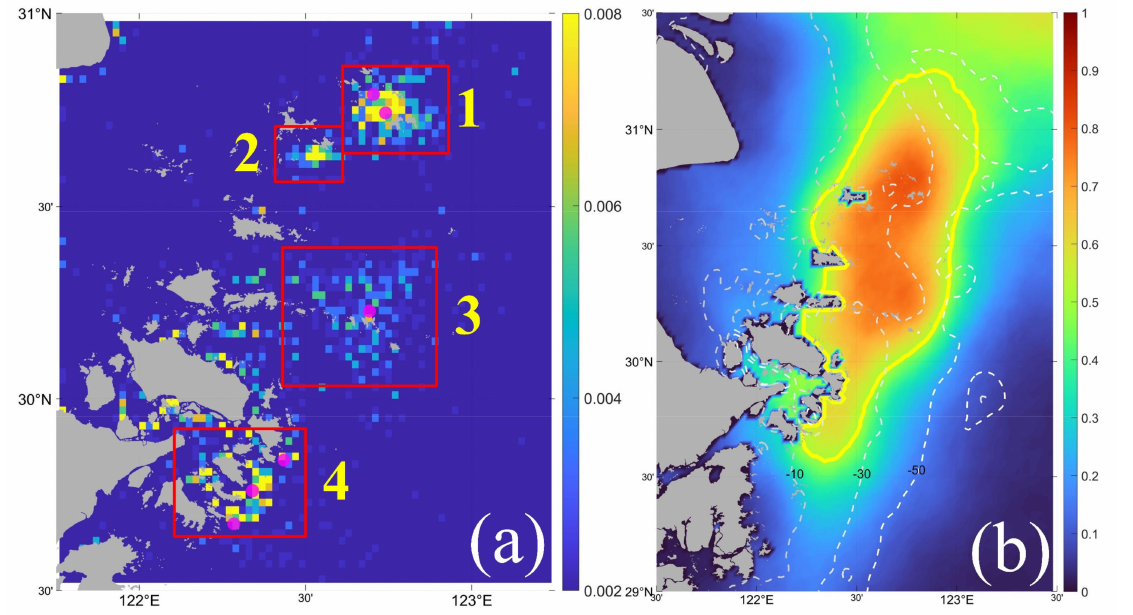
Figure 7. The spatial cumulative frequency map of potential upwelling points ( a ) and core area ( b ) from April to September, 2015–2021. The red boxes in panel ( a ) shows the aggregation area of potential upwelling points. The magenta dots in panel ( a ) show the location of the six national marine ranching demonstration areas of China. The yellow line in panel ( b ) shows the frequency contour of 0.5. The dashed lines in panel ( b ) show 10 m, 30 m, and 50 m isobaths.